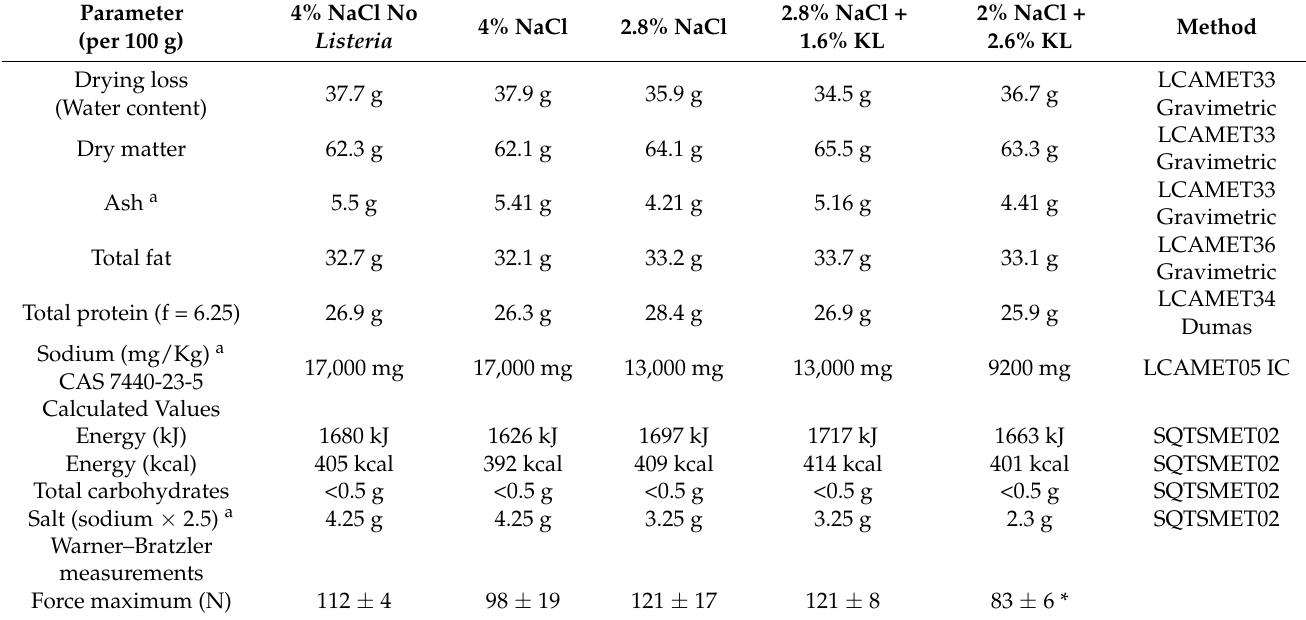
Table 6. Proximate composition and Warner Bratzler